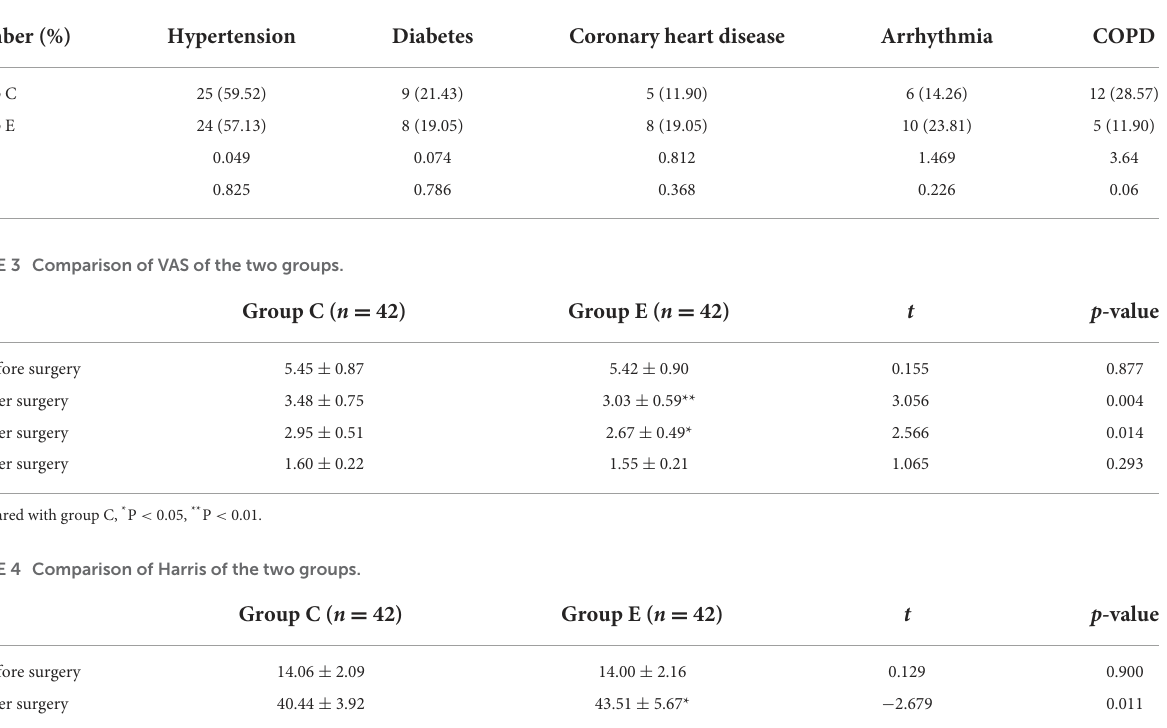
TABLE 2 Comparison of comorbidities of the two groups.